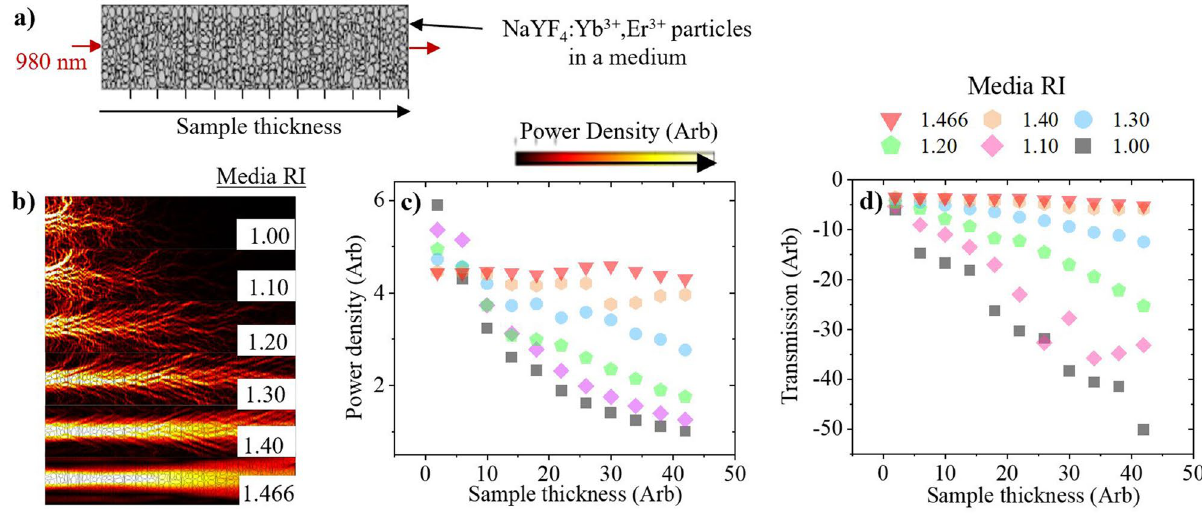
Figure 2. Simulations of a 980 nm beam propagating through powder (n = 1.466) with different sample thicknesses and embedded in a medium of varying RI, as depicted in ( a ) Media RI = 1 (grey square), 1.1 (rotated pink square), 1.2 (green pentagon), 1.3 (blue circle), 1.4 (orange hexagon), and 1.466 (red triangle). At maximum thickness, the simulated PD of various RI media is given in ( b ). The following is measured over the entire sample geometry and presented against sample thickness: ( c ) average PD, and ( d ) incident beam